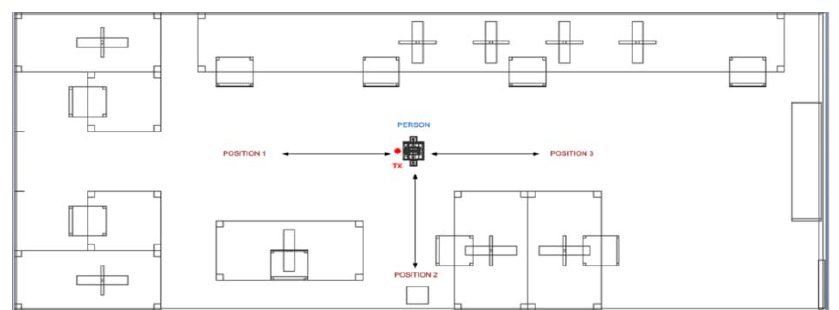
Figure 9. Layout of the measurement